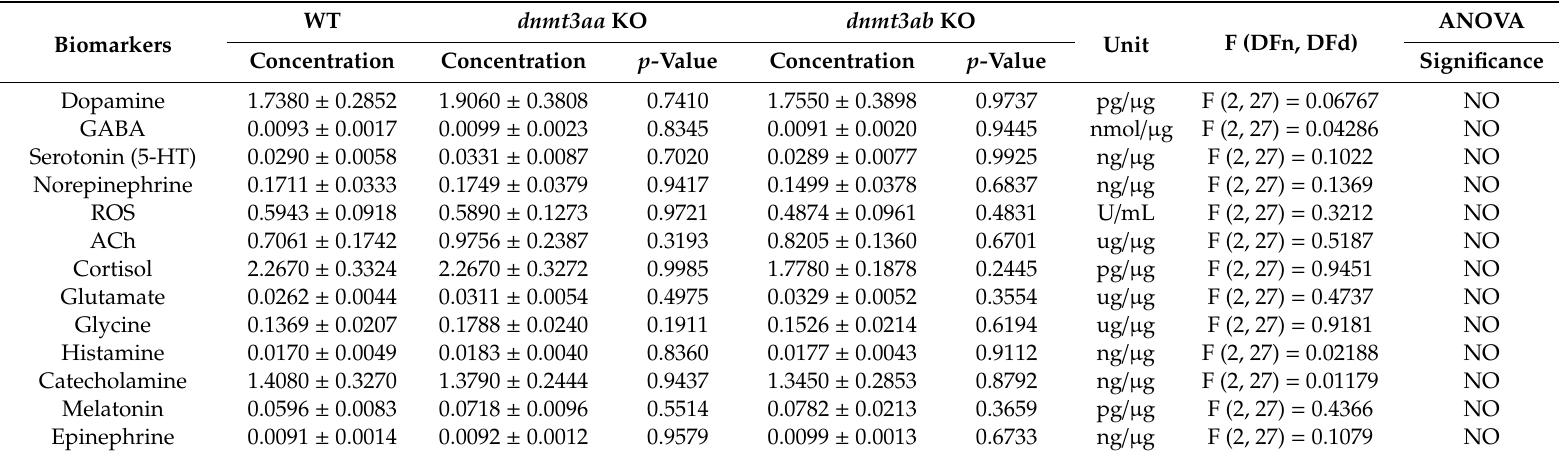
Table 1. Comparison of neurotransmitter and other biomarker levels in the brain of wild type (WT), dnmt3aa KO, and dnmt3ab KO zebrafish. The data are expressed as the mean with S.E.M. and analyzed by one-way ANOVA followed by Fisher’s LSD post hoc test ( n = 10 for all groups).